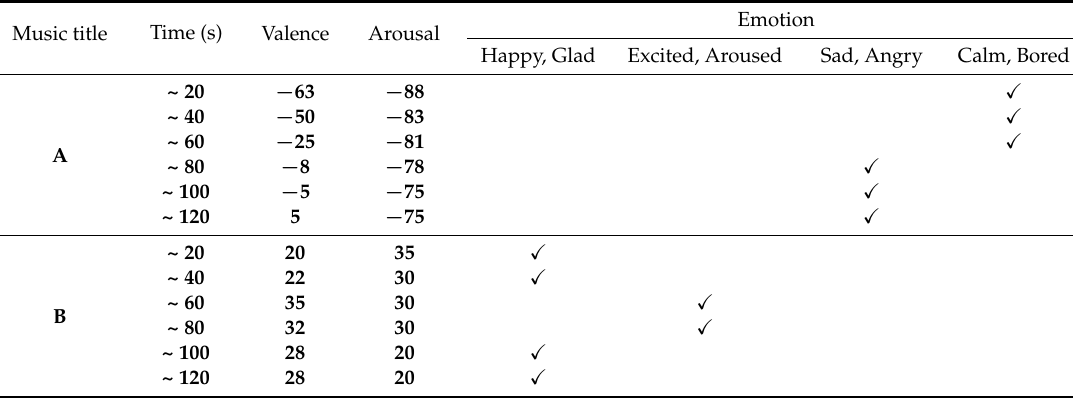
Table 1. Example of the form of the